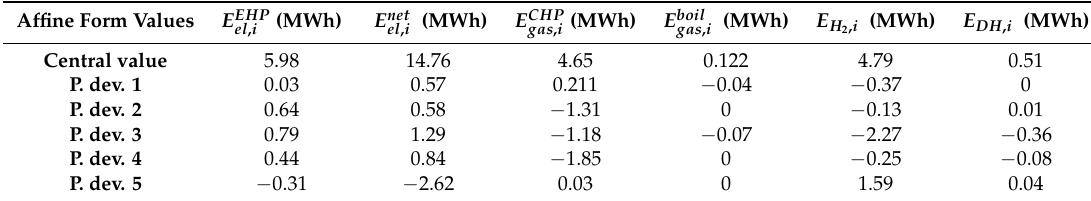
Table 3. Central value and partial deviations for each affine form.